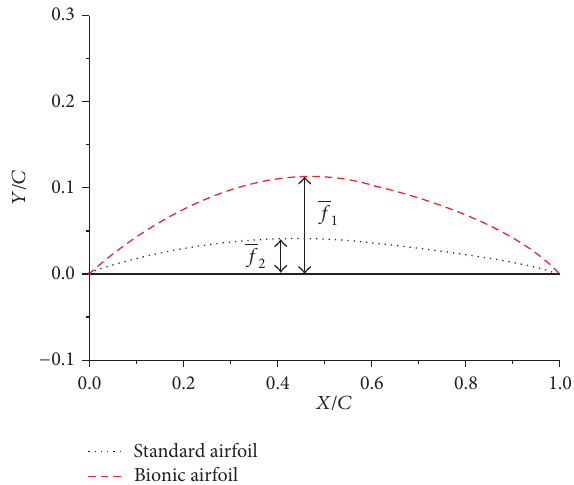
Figure 14: Mean cambers of the airfoils.